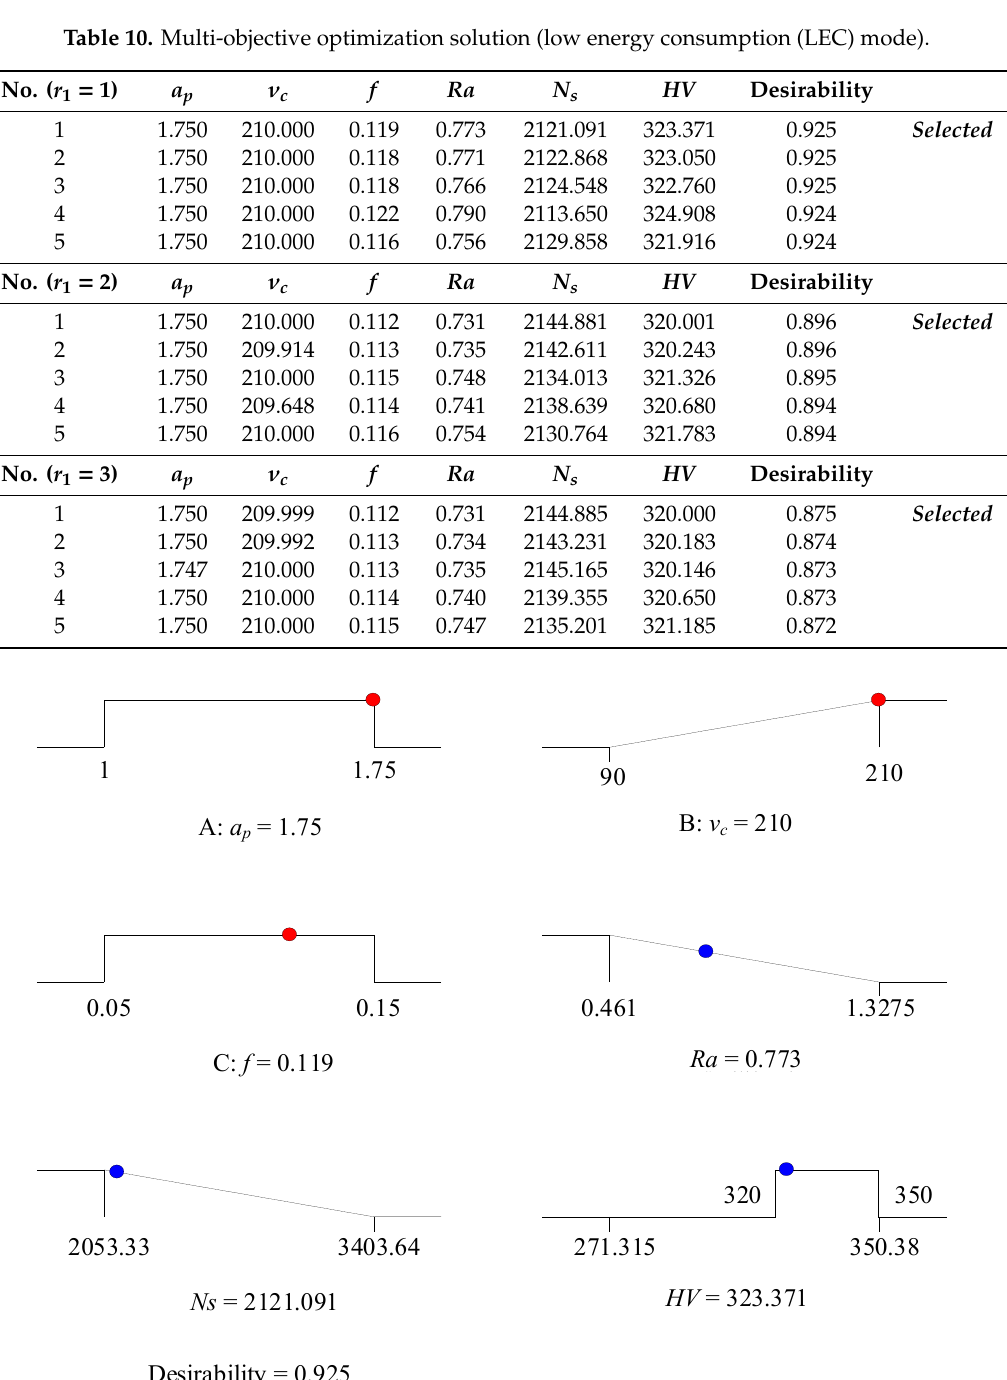
Figure 14. Ramp function graph of desirability (LEC Mode).